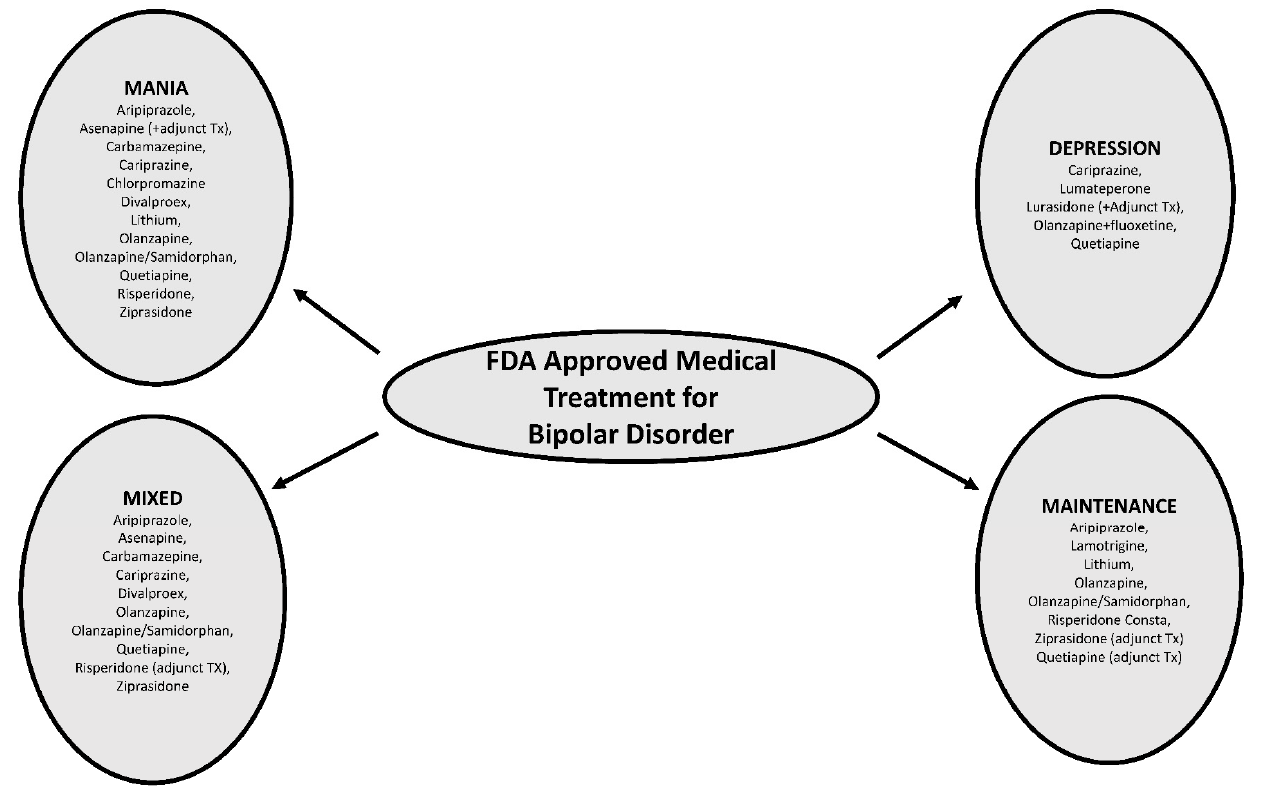
Figure 1. The FDA-approved pharmacotherapeutic medications for bipolar disorder. (Dexmedetomidine was recently FDA approved for agitation in bipolar disorder).